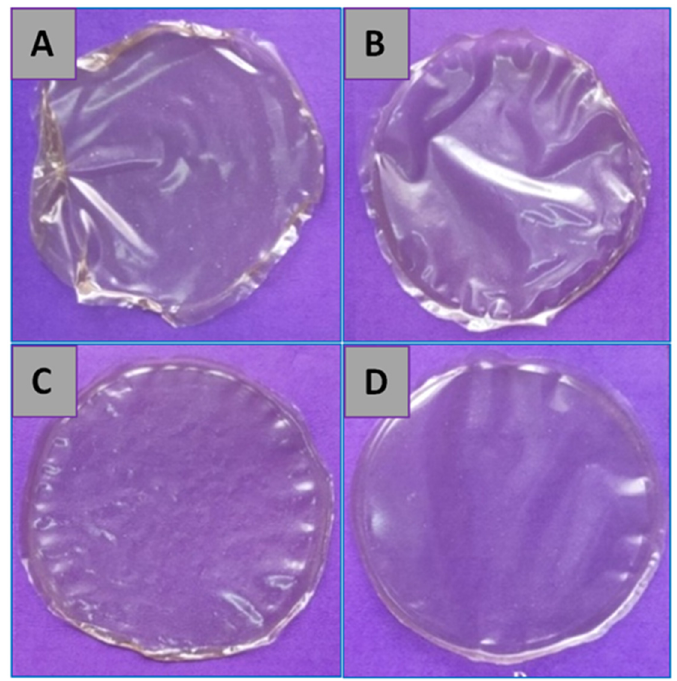
Figure 3. Photographs of the hybrid films; ( A ) chitosan (CH) / gelatin (GL) only, ( B ) CH / GL / ZnO (1%), ( C ) CH / GL / ZnO (2%), and ( D ) CH / GL / ZnO (4%).